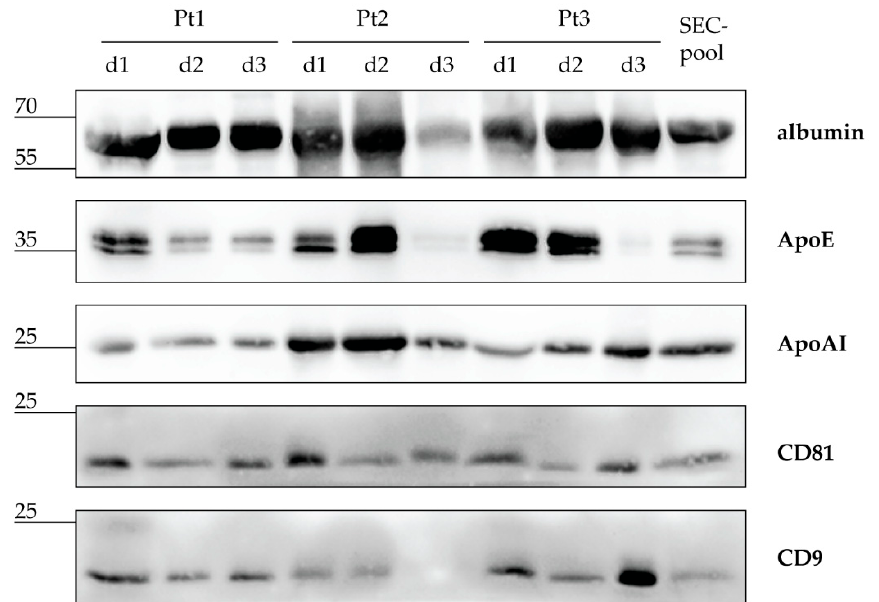
Figure 1. Intracranial cerebrospinal fluid (CSF) after severe traumatic brain injury contains EVs, lipoproteins, and albumin. CSF samples from three patients (Pt) collected during the first three days (d) after severe traumatic brain injury were pooled in equal volumes to make a CSF sample (CSF-pool) for size exclusion chromatography (SEC). Individual CSF samples and the CSF-pool were separated by electrophoresis and analysed by immunoblot with antibodies against albumin, apolipoprotein (Apo) E and AI, and EV proteins CD81 and CD9. Sizes of detected proteins are indicated in kilodaltons. Table 2. Design and performance of four size exclusion chromatography (SEC) methods based on gravity flow and applied to separate cerebrospinal fluid from patients with severe traumatic brain